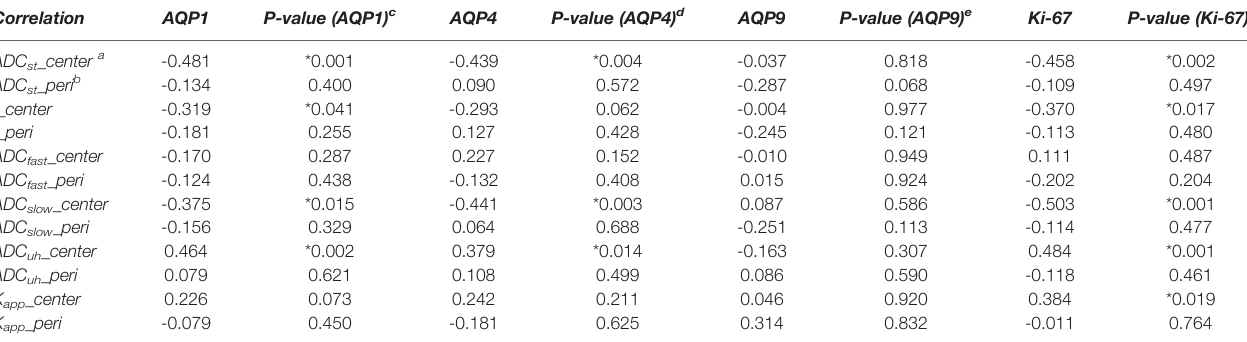
TABLE 2 | Results of correlation analysis between DWI-Derived imaging metrics and histological indices of AQP1, AQP4, AQP9 and Ki-67 molecular expression. Correlation AQP1 P-value (AQP1) c